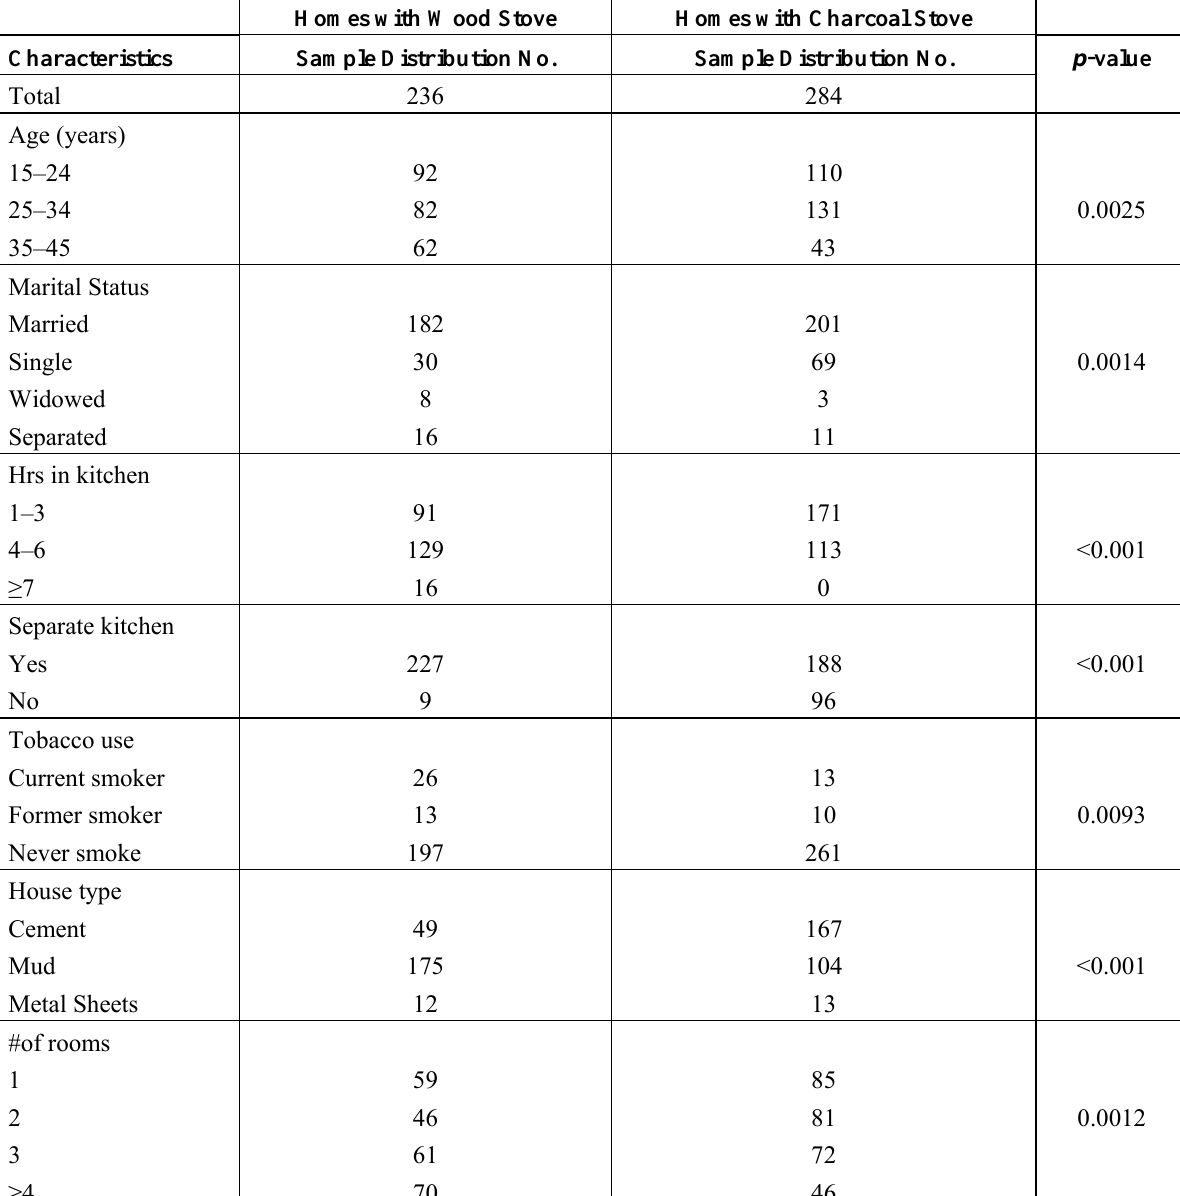
Table 1. Sample distribution of women age 15–45 years by fuel type and other variables.